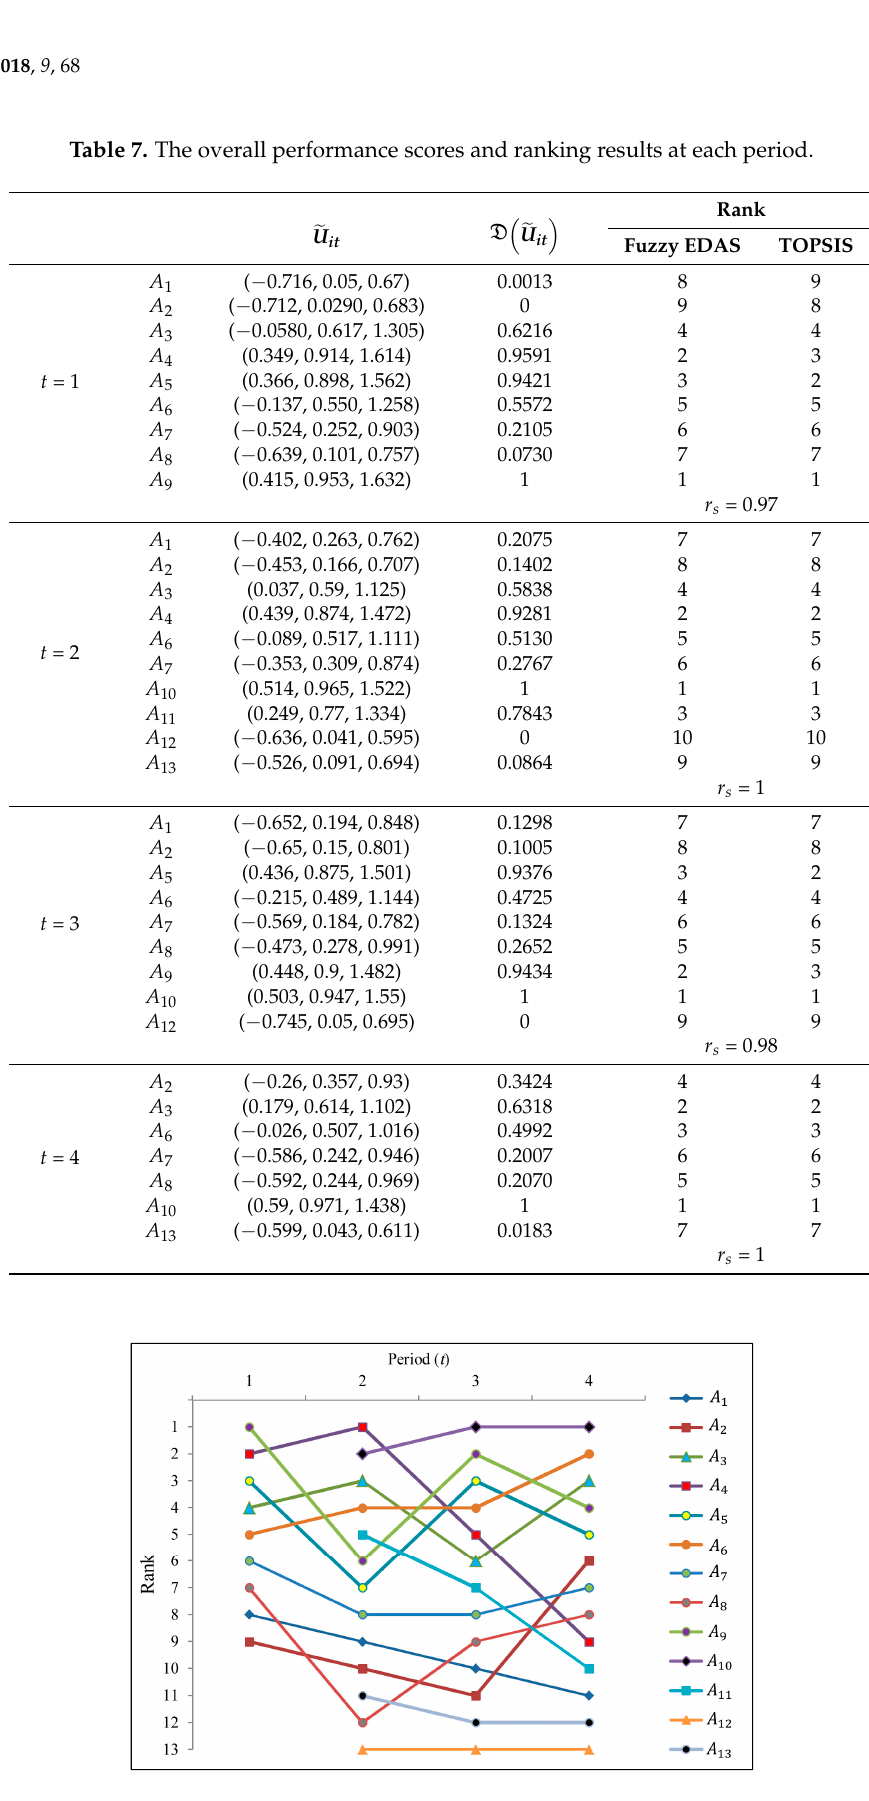
Figure 3. The changes in the rank of alternatives at different time periods.